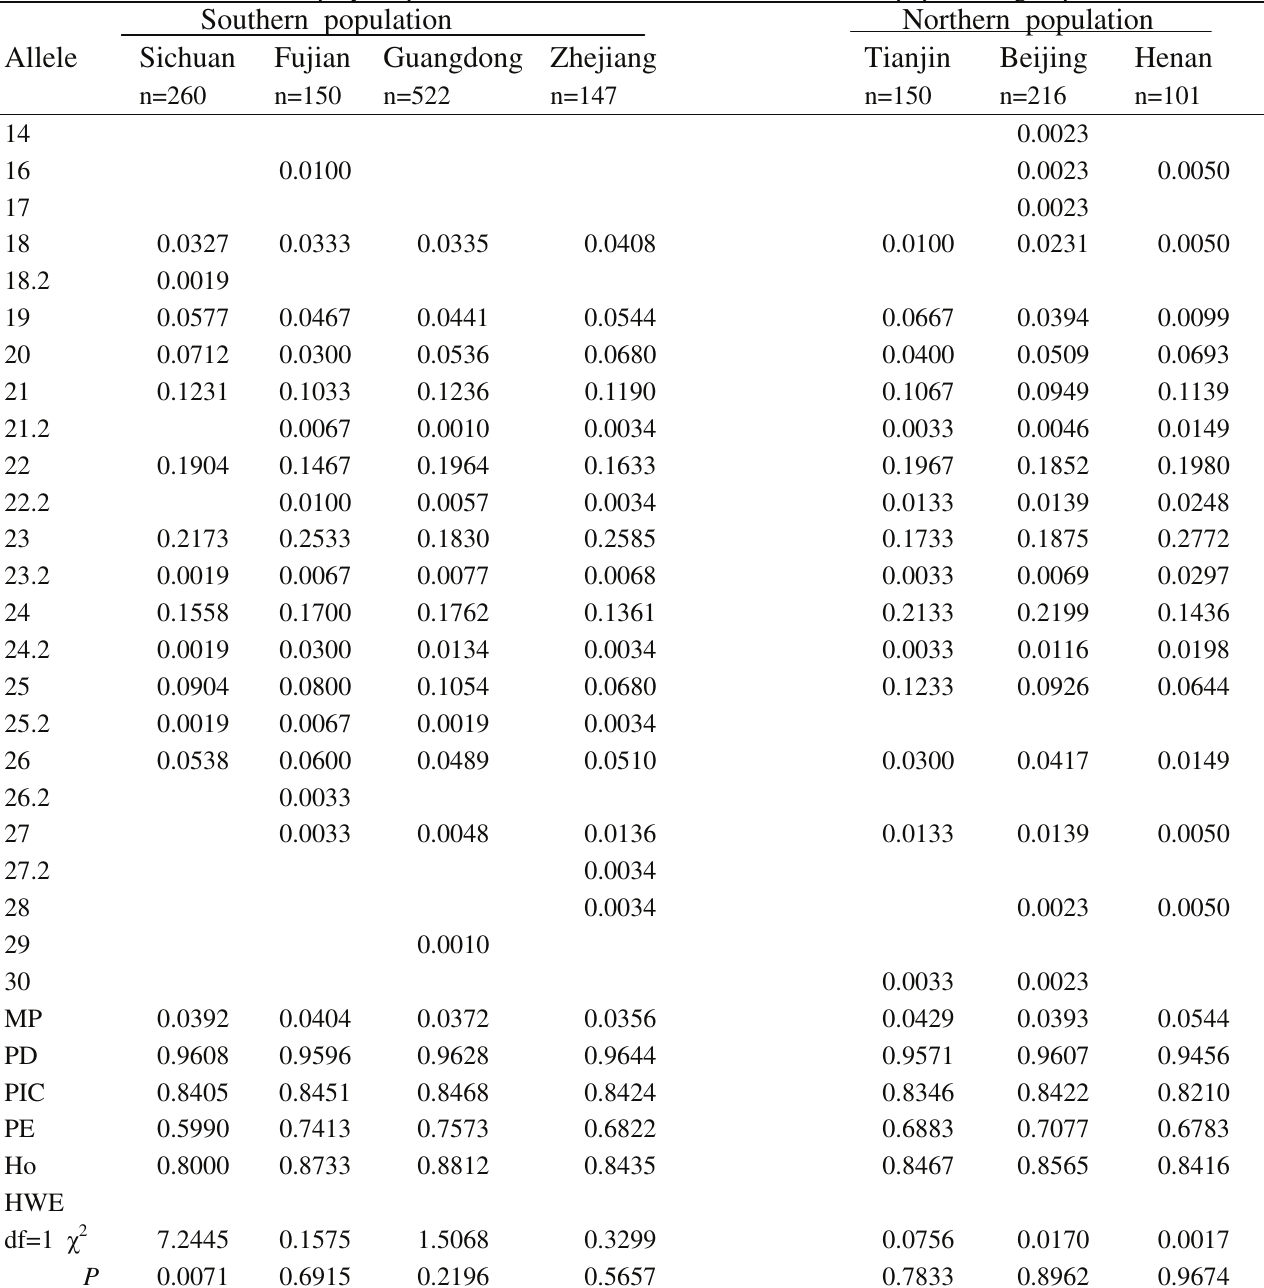
Table S8- Genetic polymorphism at the FGA locus for the seven Chinese population